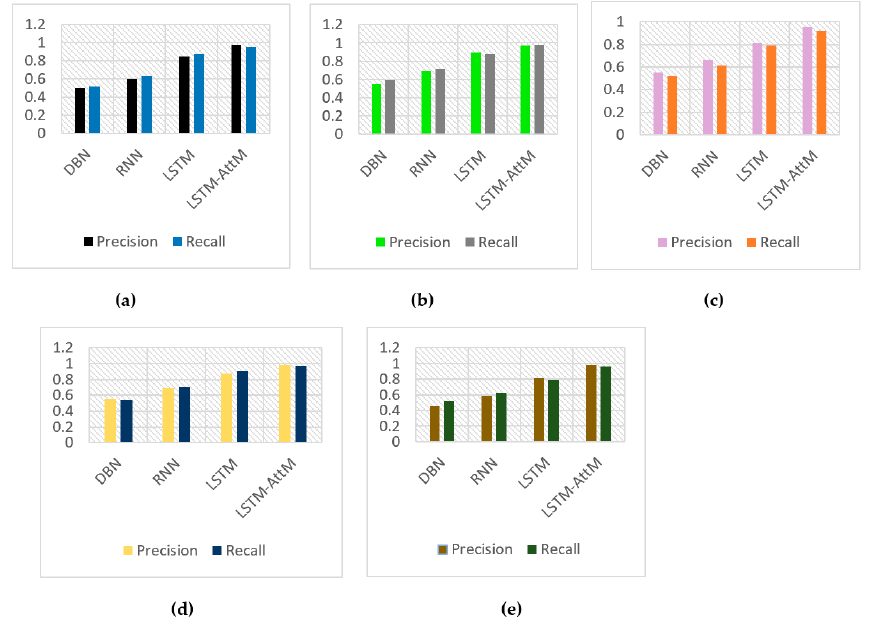
Figure 10. Comparison of precision and recall values for classification of source code with syntax errors for ( a ) Insertion Sort (IS), ( b ) Greatest Common Divisor (GCD), ( c ) Prime Numbers (PN), ( d ) Bubble Sort (BS), and ( e ) Selection Sort (SS).